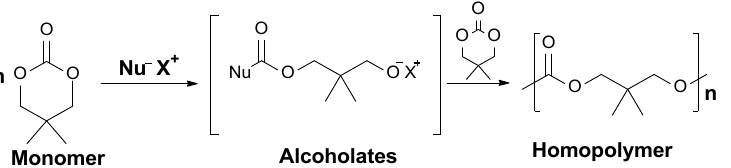
Figure 2. Opening polymerization of 2,2‐dimethyltrimethylene carbonate via anionic initiation [20].